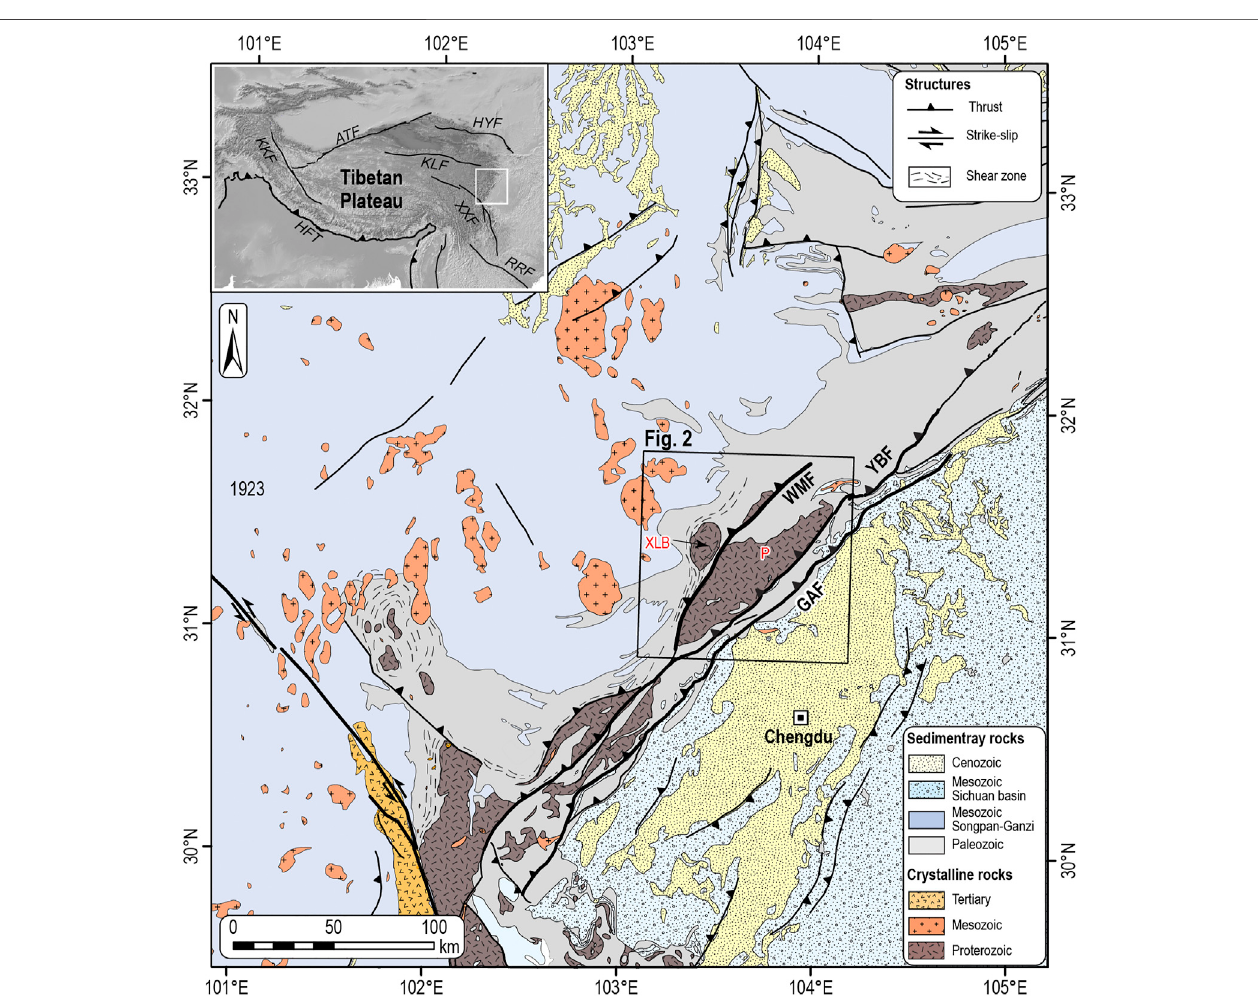
FIGURE 1 | Tectonic setting of the eastern margin of the Tibetan Plateau adjacent to the Sichuan Basin. Geology after Kirby et al., 2002; Airaghi et al., 2018a. Primary fault systems in the Longmen Shan region are abbreviated as follows: GAF, Guanxian – Anxian Fault; YBF, Yingxiu – Beichuan Fault; WMF, Wenchuan – Maowen Fault. Inset map shows location of study area relative to the Tibetan Plateau and major active faults. HFT, Himalayan Frontal Thrust; KKF, Karakorum Fault; ATF, Altyn Tagh Fault; HYF, Haiyuan Fault; KLF, Kunlun Fault; XXF, Xianshuihe – Xiaojiang Fault; and RRF, Red River Fault.